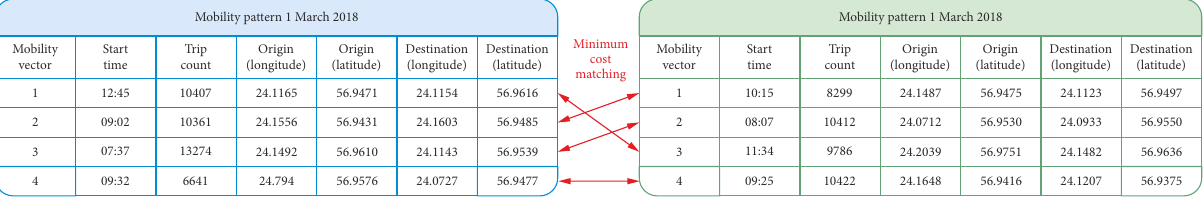
Minimum cost matching